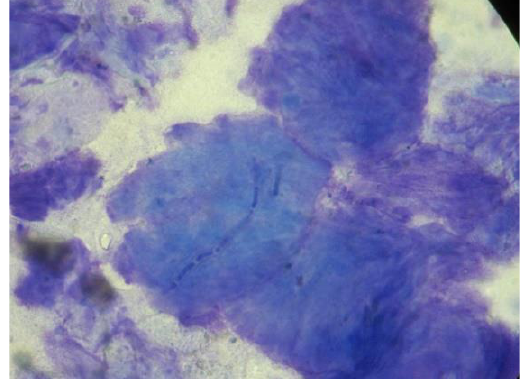
Figure 1. Adhesive tape impression cytology from a dog with dermatophytosis showing a hypha on the surface of a corneocyte (100×).